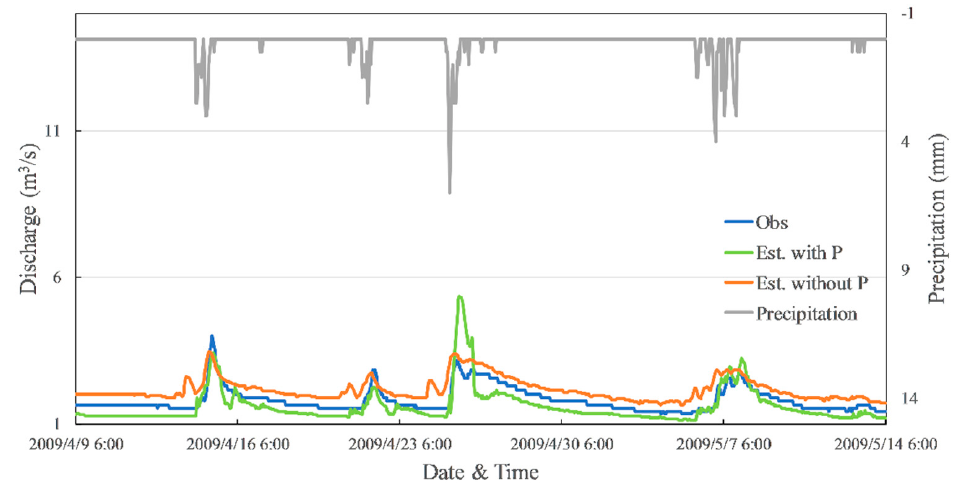
Figure 12. Influence of precipitation on the estimation results.